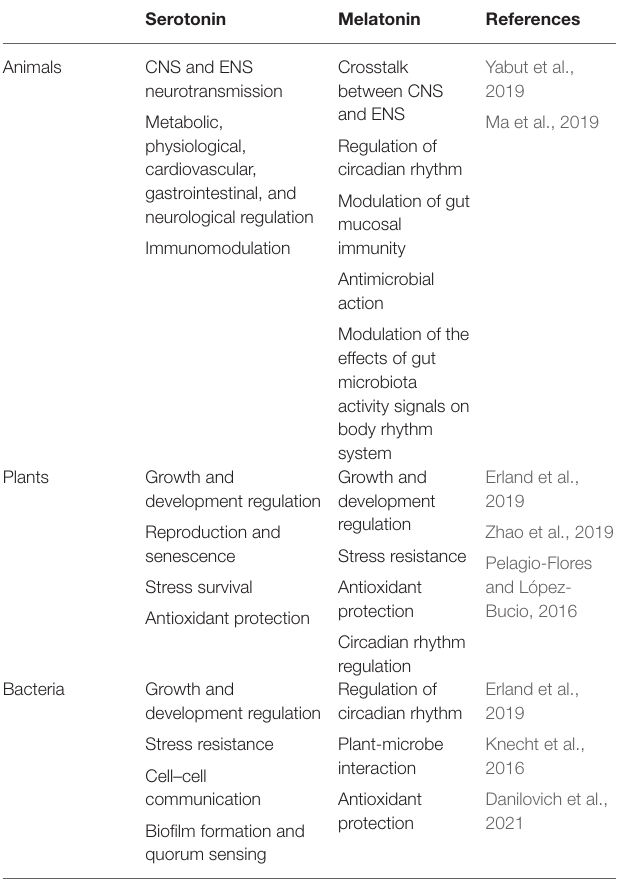
TABLE 1 | Serotonin and melatonin functions in animals, plants, and